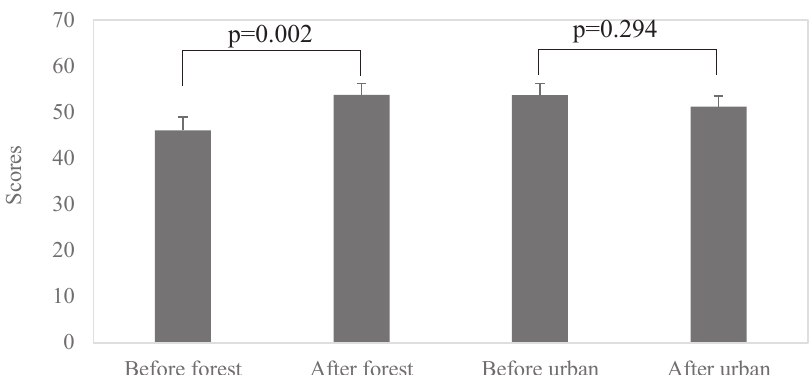
Fig. 6 E ff ect of forest bathing on subjective sleep quality (feeling refreshed, recovery from fatigue). p = 0.002, between before and after forest bathing, p = 0.294 between before and after walking in the urban area by paired t-test (Mean + SD, n = 10). “ Before forest ” means before the forest bathing, “ After forest ” means after the forest bathing, “ Before urban ” means before the walking in the urban area, and “ After urban ” means after the walking in the urban